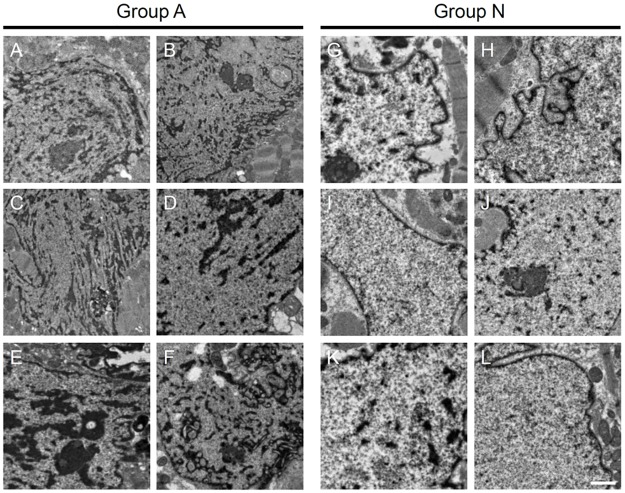
Representative Nuclei of 6 Patients from Each Group.Representative images are shown for each group. Six patients from Group A (A)–(F). Six patients from Group N: (G)–(L). Scale bar: 2 μm.